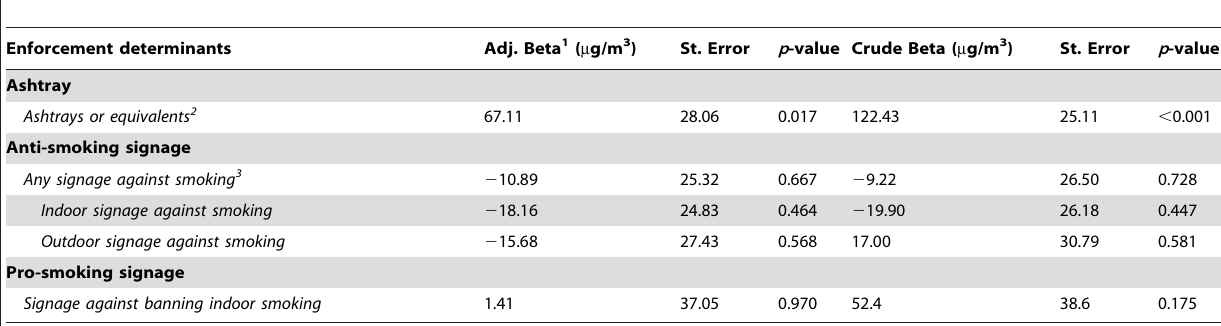
Table 6. The relationship between ashtrays and signage within venues (n=151) and adherence to a smoke-free legislation, within Waves 3 and 4 of the Hellenic Air Monitoring Study Greece,